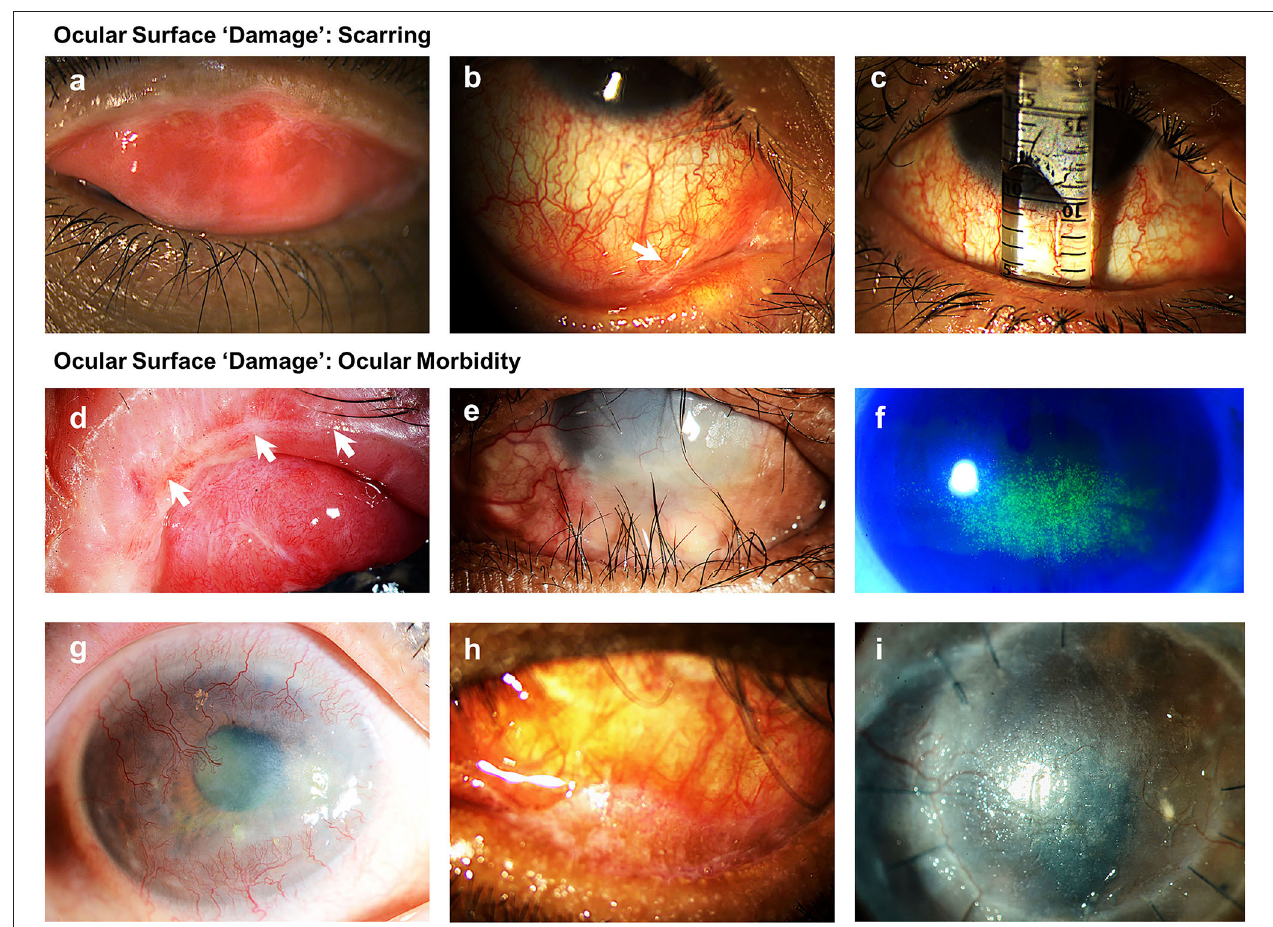
FIGURE 2 | Examples of clinical manifestations of ocular surface “damage” related to scarring and ocular morbidity. (a) Subepithelial fibrosis; (b) presence of symblepharon; (c) conjunctival forniceal foreshortening illustrated using a fornix depth measurer; (d) disruption to meibomian glands and mucocutaneous junction; (e) trichiatic and distichiatic lashes; (f) superficial punctate keratopathy; (g) four quadrant central and peripheral corneal vascularization with opacification; (h) conjunctival and lid margin keratinization; (i) corneal